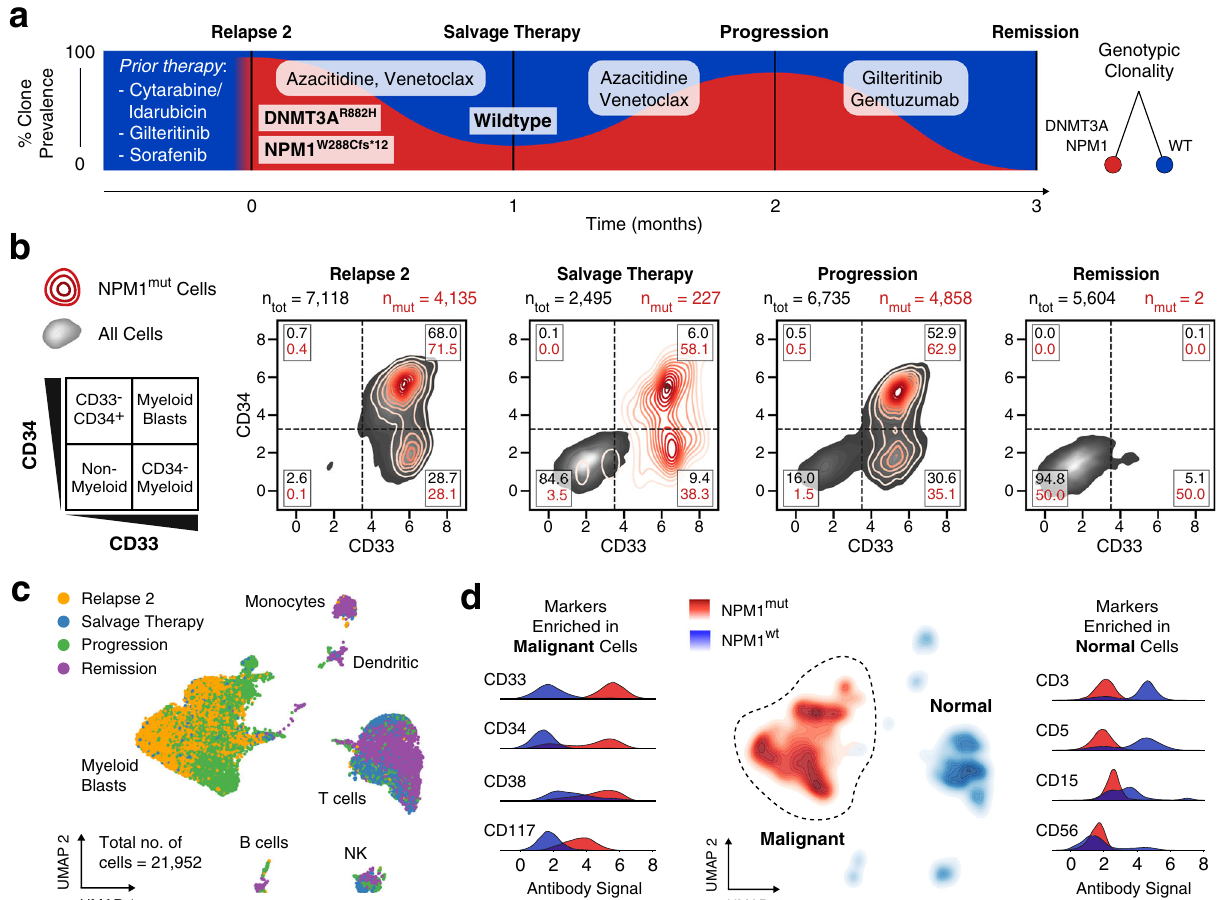
Fig. 3 AML blasts exhibit a stable genotype and phenotype through treatment. a DAb-seq performed on four bone marrow aspirates of a patient with AML during disease progression as indicated in the fi shplot (black lines). The patient received multiple rounds of chemotherapy prior to the experiment (Supplementary Table 4). The fraction of blast cells with NPM1 W288Cfs*12 (NPM1 mut ) mutation for each sampled timepoint detected by DAb-seq are shown in red. b Scatter plots with kernel densities show CD33 and CD34 signal for all cells (grey) and NPM1 mut cells (red) for each of the sampled timepoints. The percentages of normal and mutant cells within each gate are listed. Virtually gating cells highlights a persisting CD33 + blast population, which is eradicated with gemtuzumab, a CD33-targeted therapy. c UMAP embedding based on the log-transformed and corrected antibody counts from all cells labeled by timepoint indicates that the high-dimensional immunophenotype of the blasts is stable over the sampled timepoints. d The genotype of each cell at the NPM1 locus is plotted as a kernel density estimate using the UMAP coordinates from c . Antibody signals enriched among malignant and normal populations are plotted as kernel densities using all cells and labeled by genotype. Source data are provided as a Source data fi